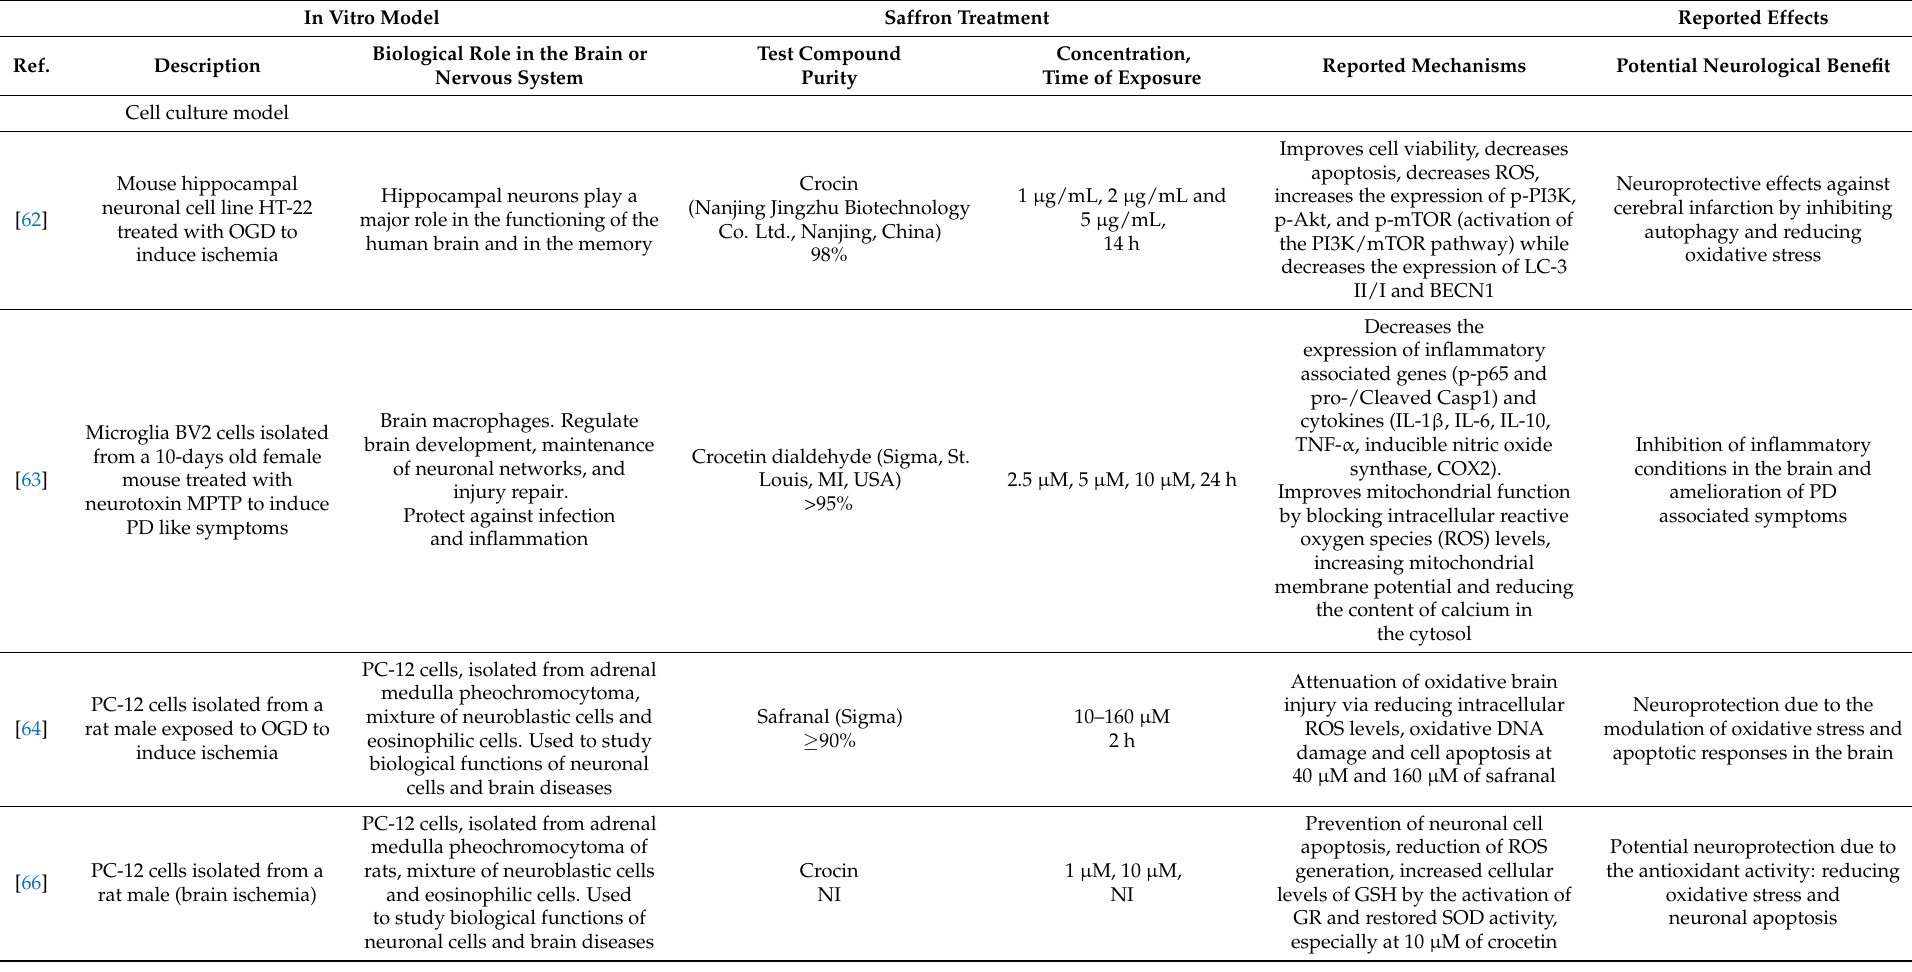
Table 4. In vitro studies looking at the effects of saffron and its main bioactive constituents against neurological